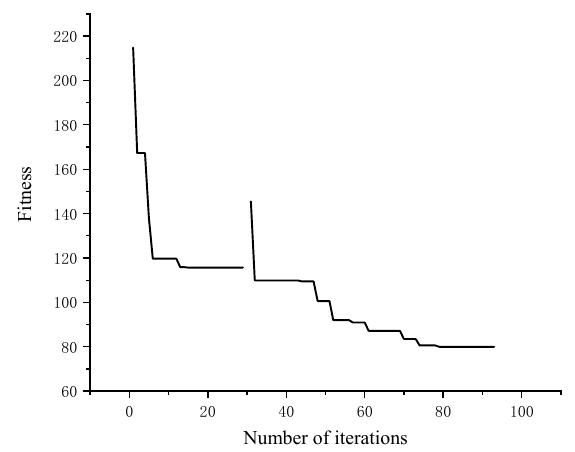
Figure 31. Fitness of EPA-PSO algorithm after 100 iterations.